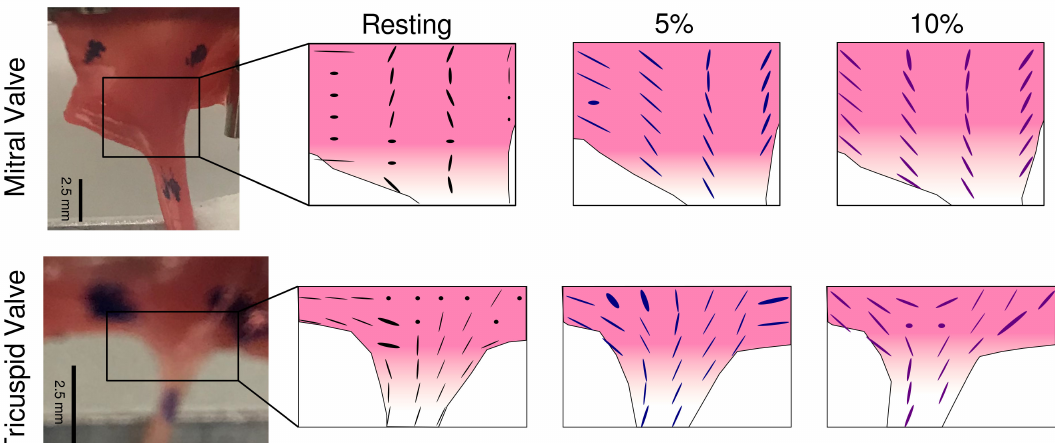
Figure 3. Local collagen fiber alignment calculated from 2-D XRD scans on ‘bisected’ CT–LL samples from TV and LV. The alignment at each datapoint is represented as an ellipse. As is observed with the 5% and 10% stretch series, more fibers become more aligned with increased overall strain applied on the